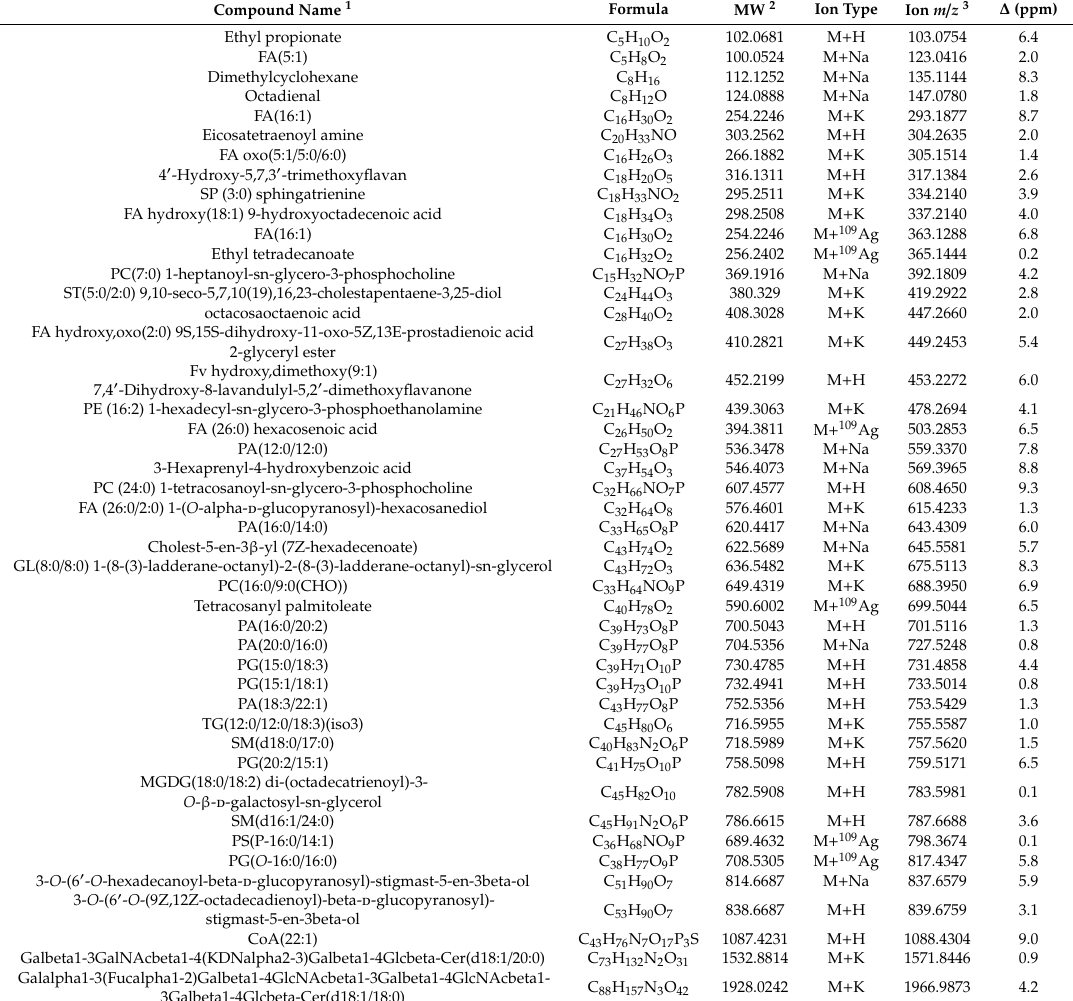
Figure 2. SEM images of polyester fibers surface before and after fabric modification (magnification 1000×); ( a )—Control sample (before modification); ( b )—After impregnation with beeswax suspension and drying at room temperature; ( c )—Sample b after heat treatment at 120 °C for 1 min.